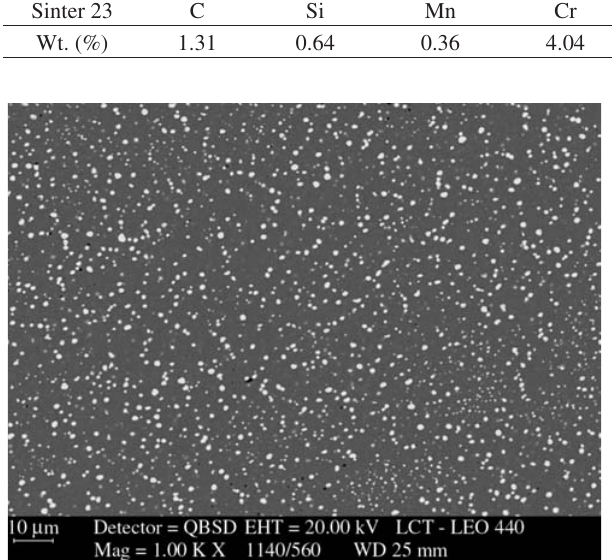
Figure 1. Scanning electron micrograph of Sinter 23 austenitized at 1140 °C and tempered at 560 °C.